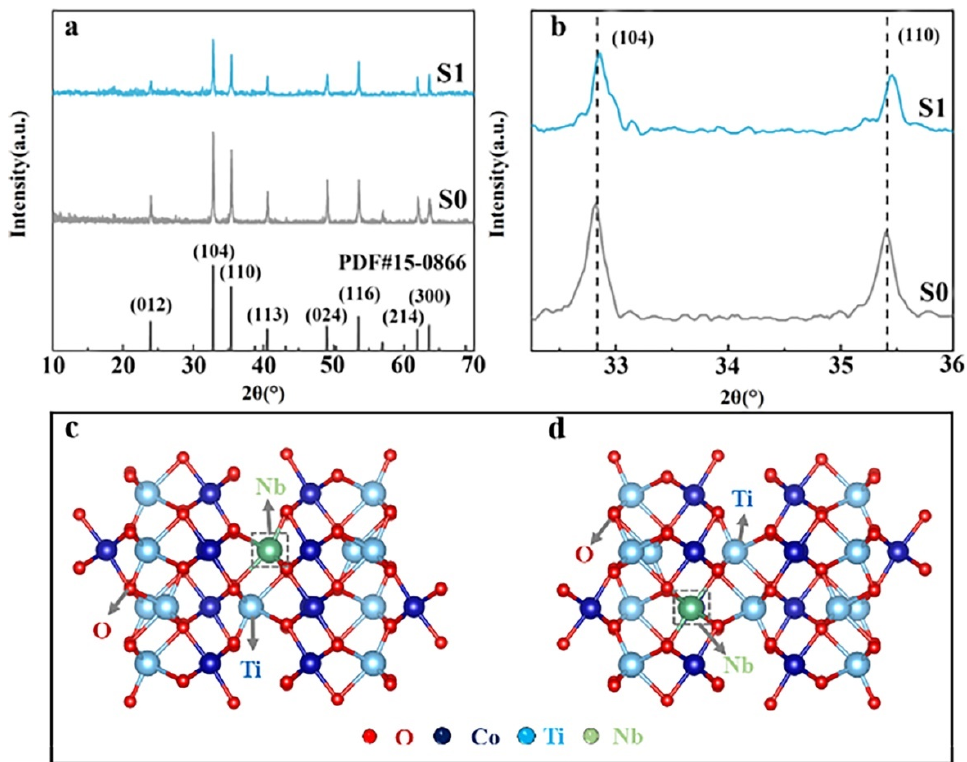
Figure 2. ( a ) XRD patterns and ( b ) the enlarged image of S0 and S1. The structure models for the replacement of ( c ) Ti and ( d ) Co sites by Nb atoms.